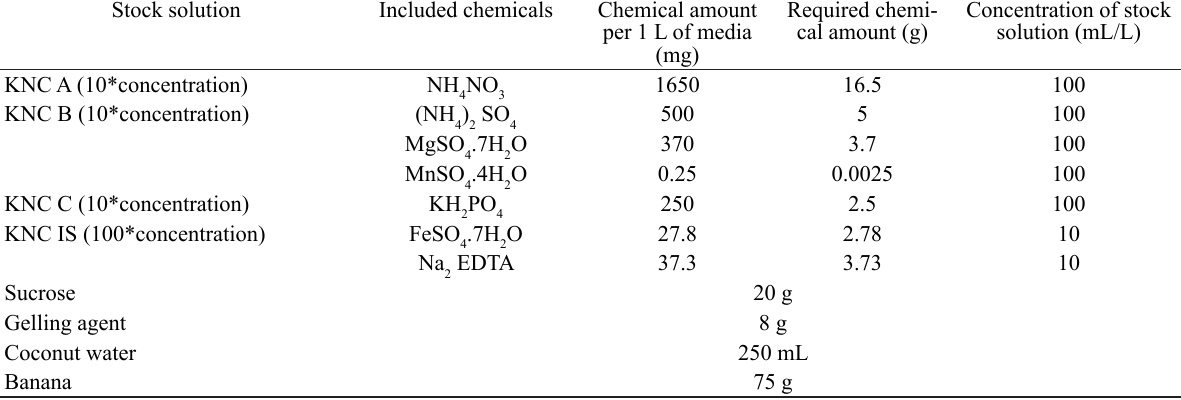
Table 2: Required chemical amounts needed to prepare one liter stock solutions of KNC media and concentrations of the stock solutions